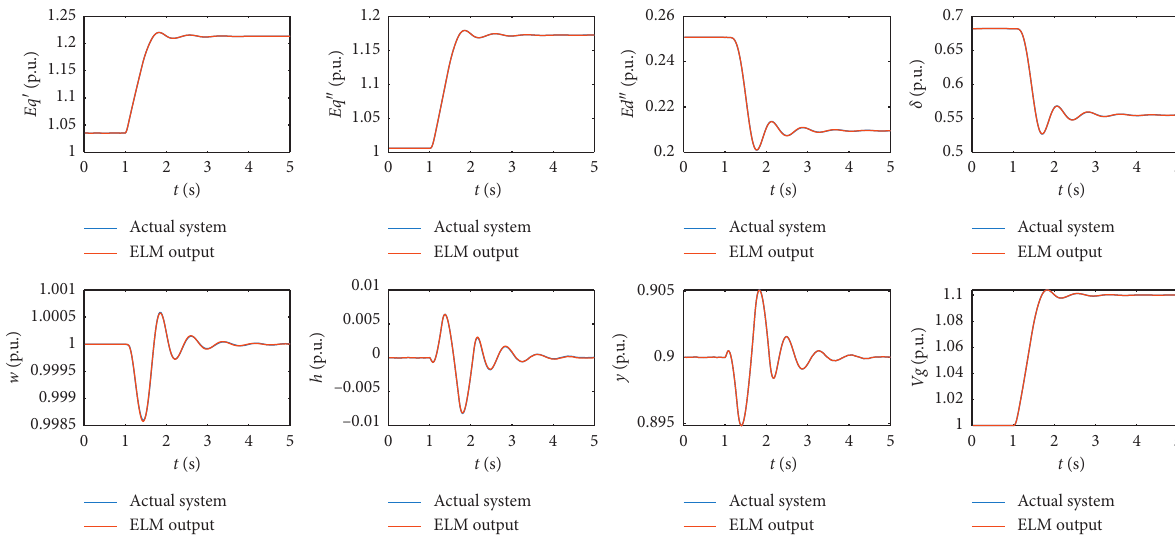
Figure 14: Comparison between the outputs of the ELM model and the actual system. Table 2: The optimized parameters of the PI controller with AVR and PSS under different conditions. Condition